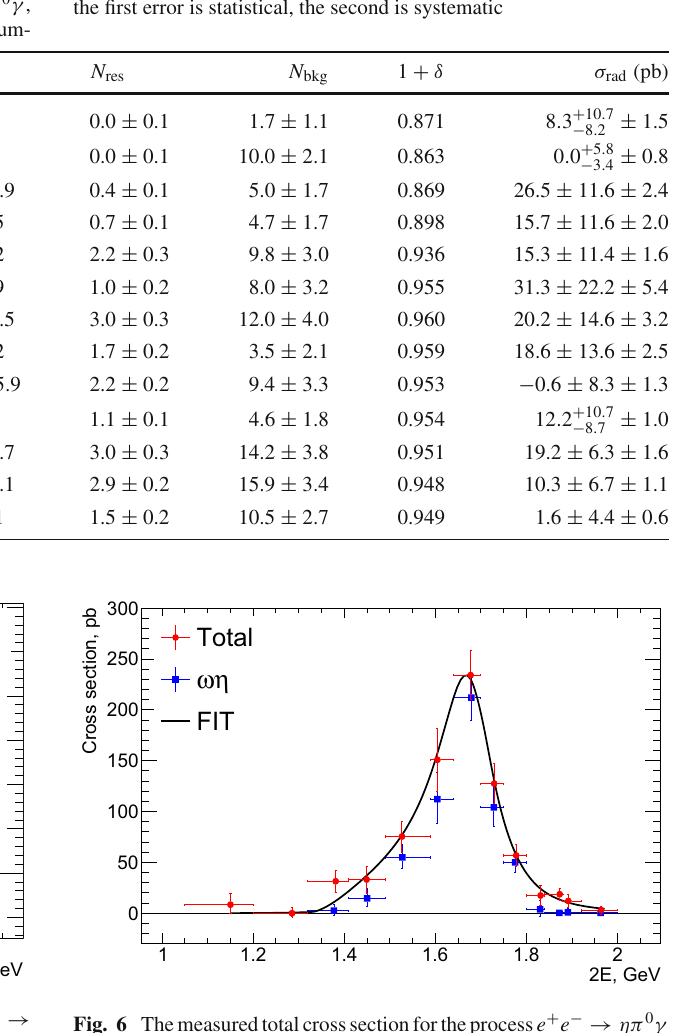
e + e − → rad- ηπ 0 γ cross section based on the prediction from Ref. [10] may reach 3–5 pb. This value is several times lower than our measurement.